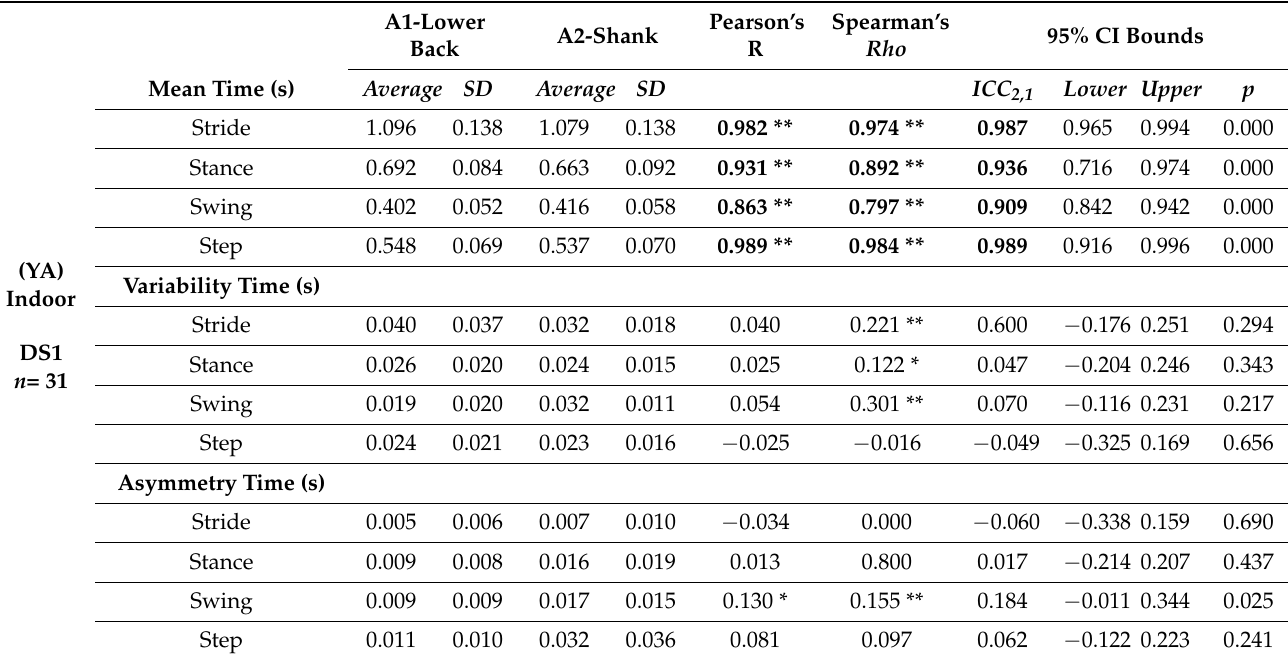
Table 3. Extracted temporal parameters and agreements for indoor